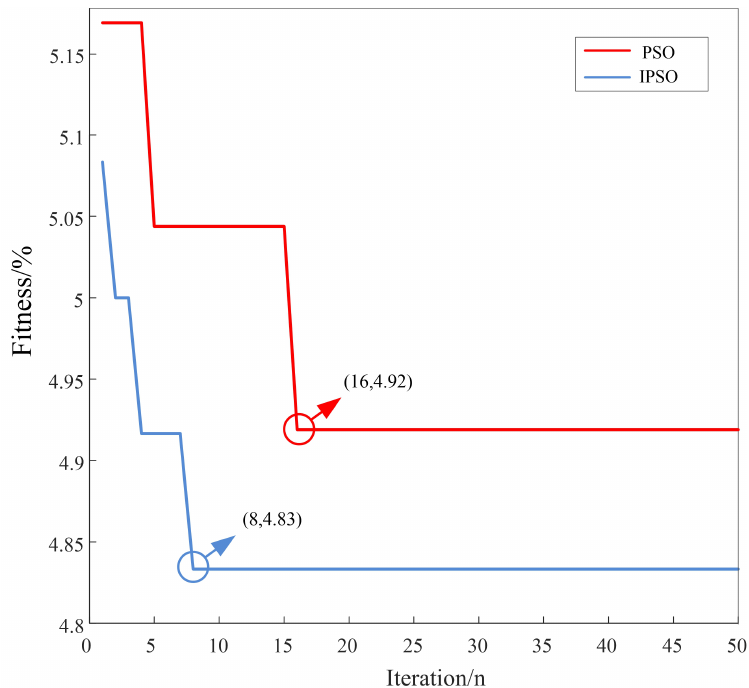
Figure 10. Iteration process diagram of IPSO-SVM algorithm (MIT-BIH arrhythmia database).